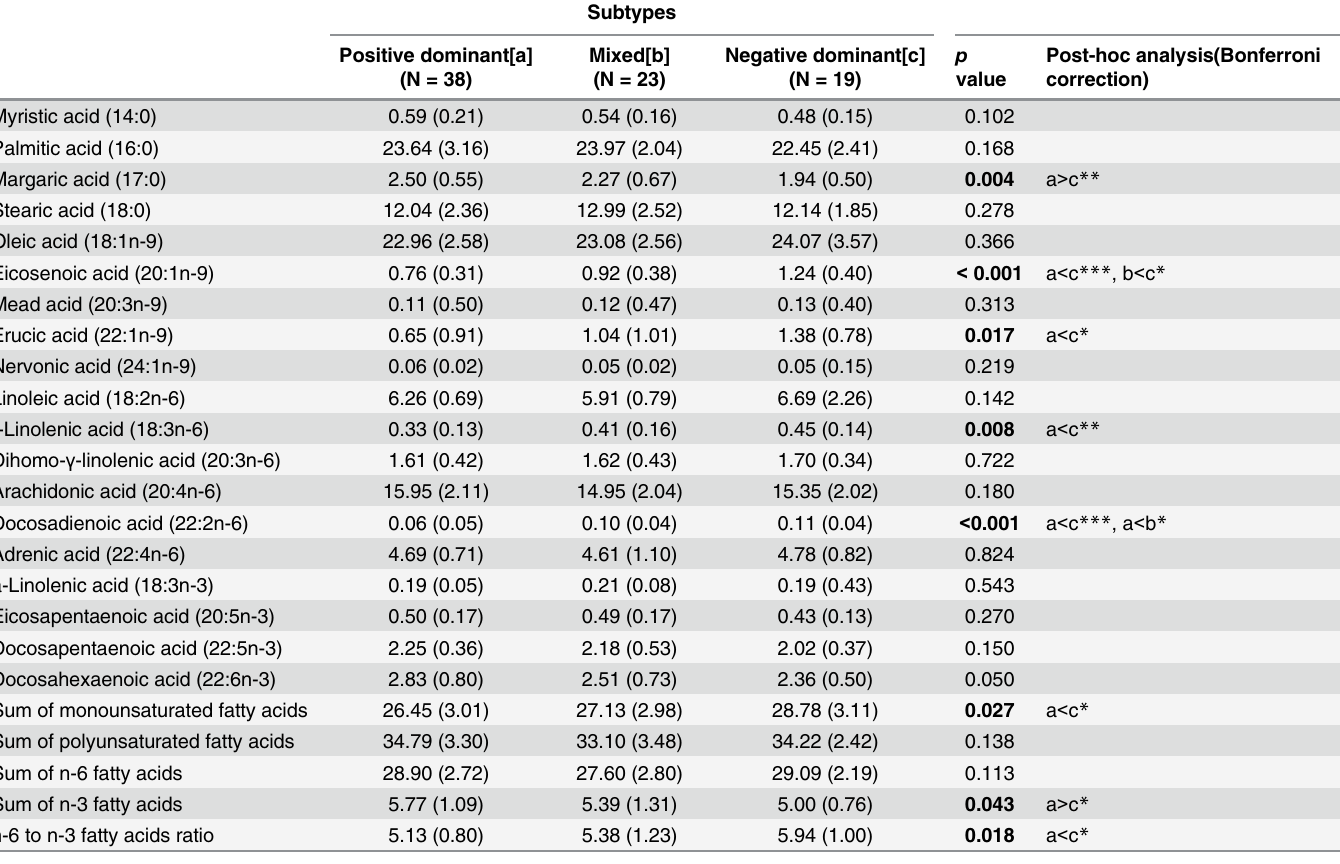
Table 3. Comparison of erythrocyte membrane phosphatidylethanolamine lipids levels according to dominance of positive or negative